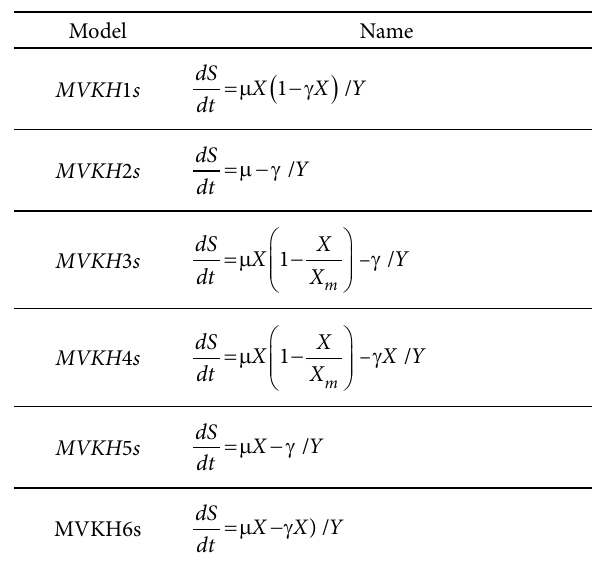
Table 2. The substrate consumption models